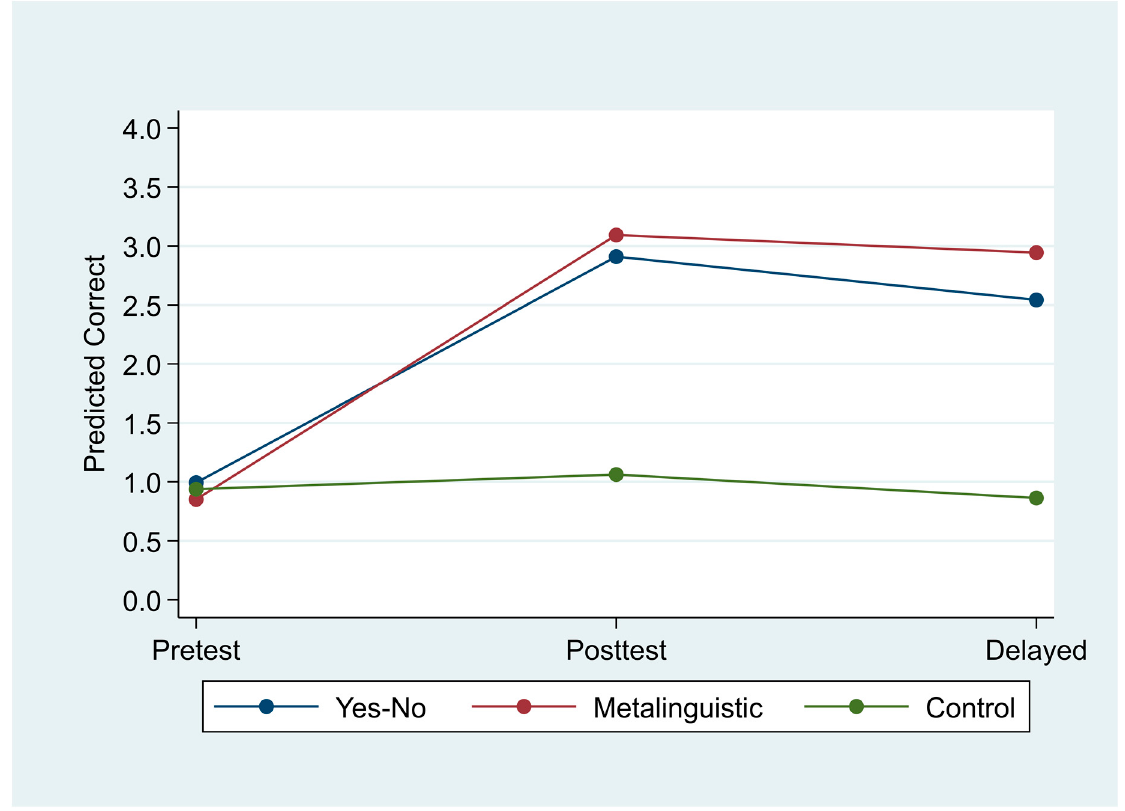
Figure 6. Predicted Probability of Accurate Interpretation in the Tense-Future Condition by Group and